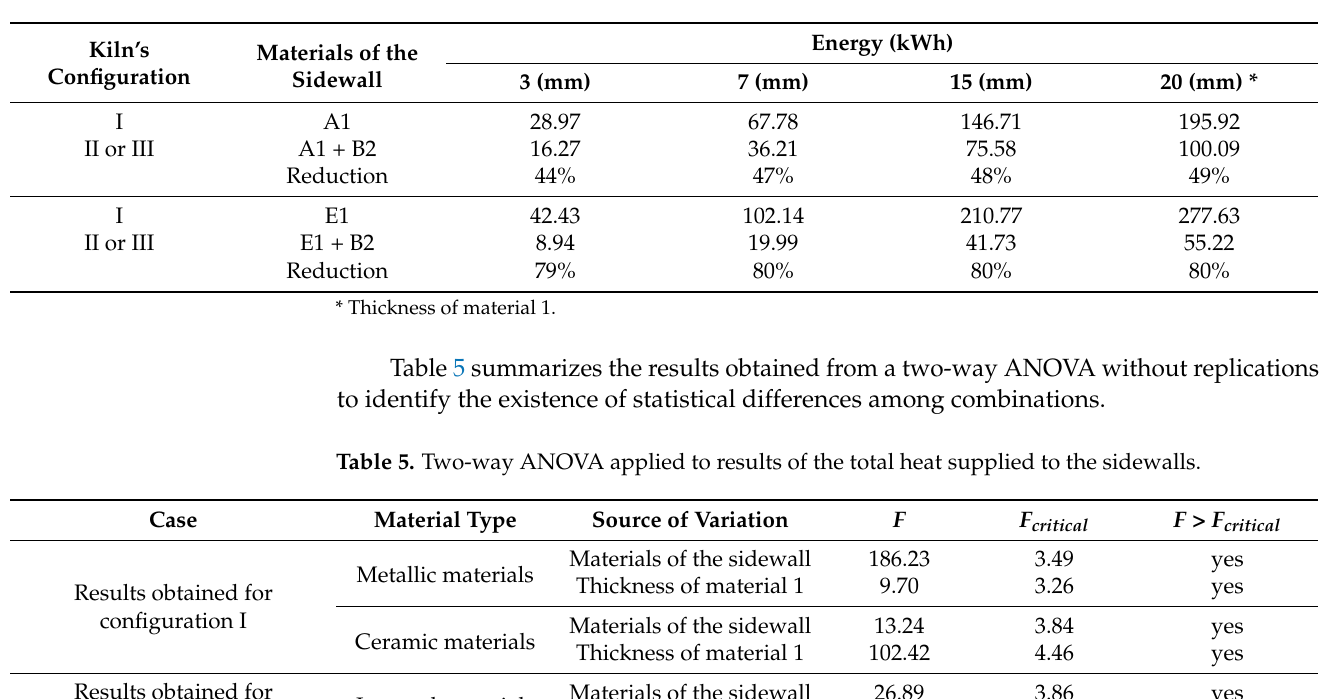
Table 4. Reduction in total heat supplied to sidewalls A1 + B2 or E1 + B2 (configuration II or III-no pivoting door) compared to sidewalls A1 or E1 (configuration I).